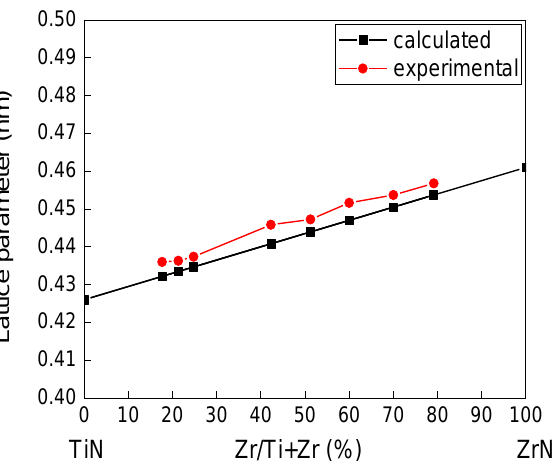
Figure 5. Lattice constant of the films obtained from the experiments and calculations using Vegard’s law.